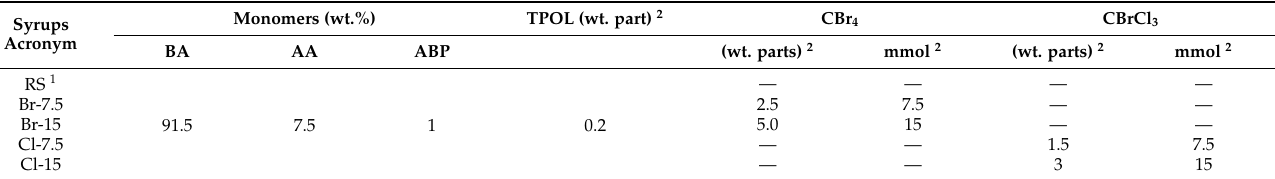
Table 1. Compositions of monomers, photoinitiator, and telogen for acrylic telomer syrups. Monomers (wt.%)